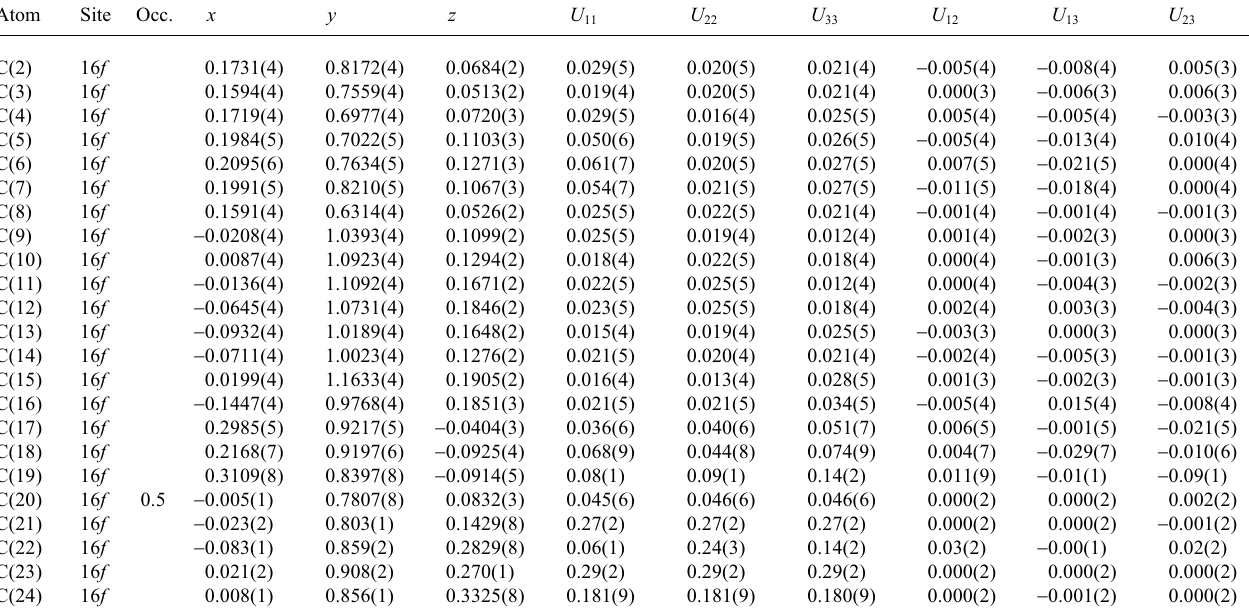
Table 3. co ntinued. Atom Site